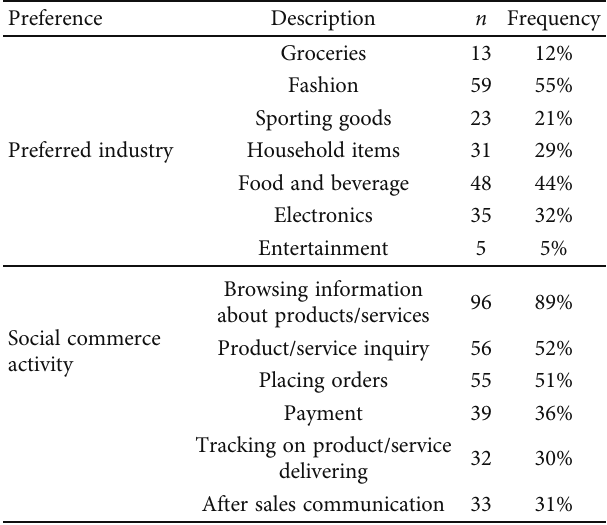
Table 5: Descriptive result of consumer ’ s social commerce